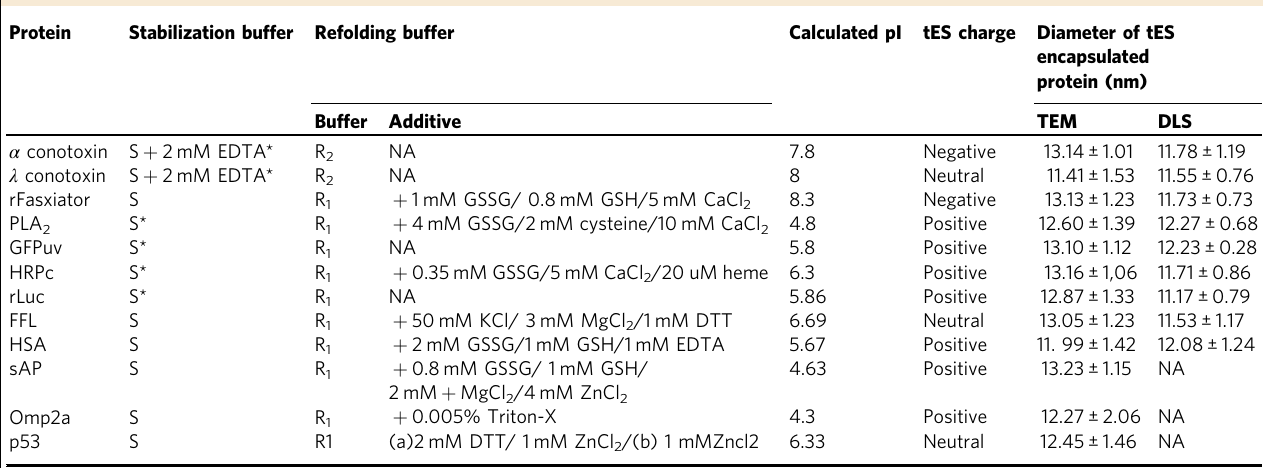
Table 1 Solubilization and refolding of proteins of interest (POIs).